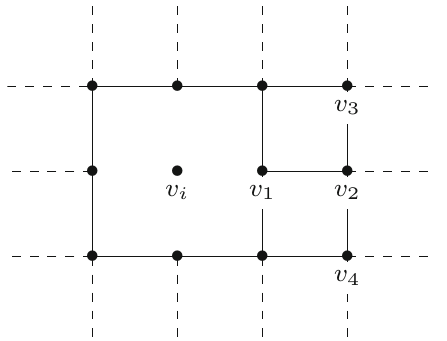
Fig. 8 A section of the emerged quantum mesh with (cid:11) k (cid:5) = 2 d = 4. Depicted is an isolated defect surrounding vertex v i , with vertices v ,v ,v ,v 1 2 3 4 labelled.Forthepurposesofdiscussionassume s i all other spins s j = | j , 1